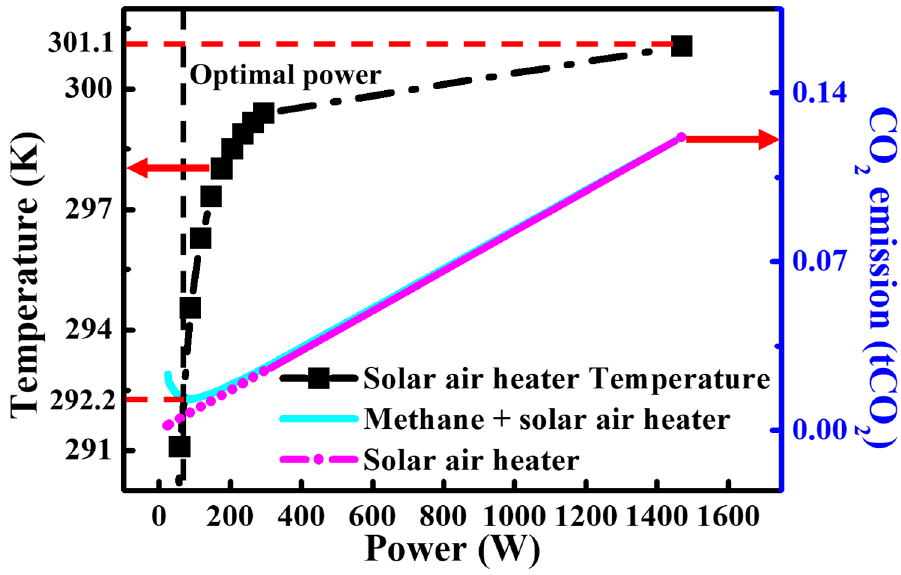
Figure 11. Indoor air temperature and tCO2 change according to the fan power of the heater in February. in Table 3. From October to February, the indoor air temperature according to the fan power of the heater.